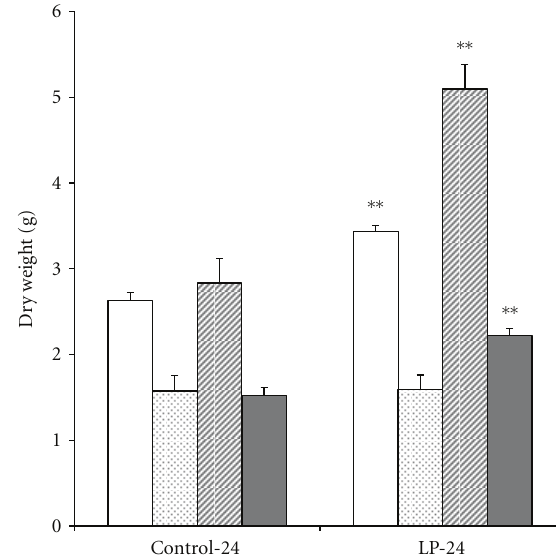
Figure 7: Dry weights of source (leaves) and sink organs (stems, floral organs or roots) in soybean plants grown with original pots (Control) and with larger pots (LP). Half of plants with age of 40 days were grown with larger pots for 24 days (Control-24 or LP- 24). Open bar, leaves; dotted bar, stems; shaded bar, floral organs; closed bar, roots. Vertical bars, S.D. ( n = 3). ∗∗ P < 0 . 01 ( t -test) when compared with